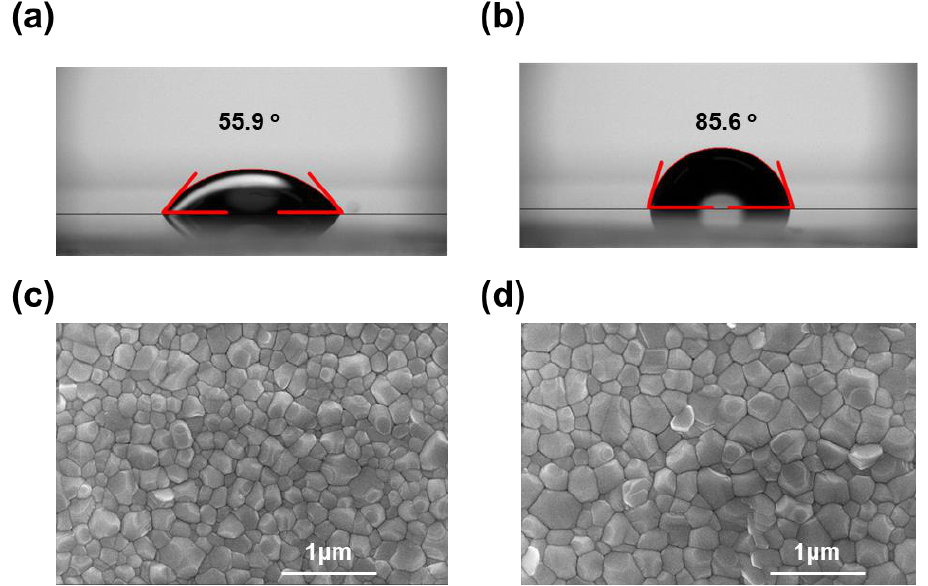
Figure 6. Contact angle images of water droplets on the surface of ( a ) NiO film, ( b ) PTAA/NiO film. Top-view SEM images of ( c ) perovskite/NiO film, ( d ) perovskite/ PTAA/NiO film.